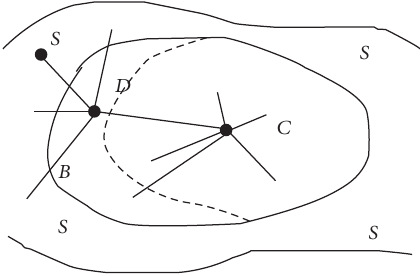
Figure 1: Definition of local